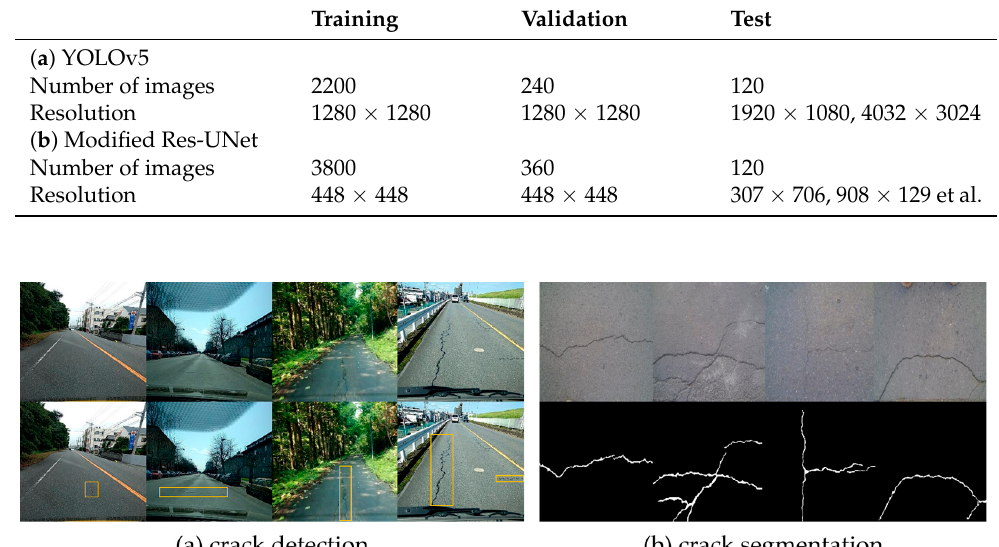
Table 1. Image dataset for crack detection and segmentation.